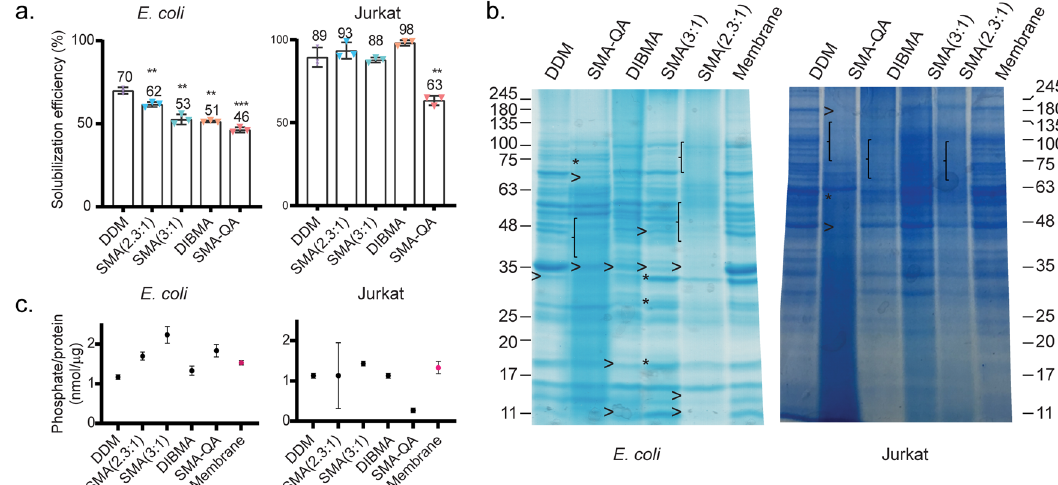
Fig. 2 Solubilization of E. coli and Jurkat membrane pellets with DDM and different xMAs. a Protein solubilization ef fi ciency, as measured by BCA assay of soluble and insoluble fractions after solubilization with DDM or xMAs. Data correspond to three technical replicates. Error bars represent ±S.D. Signi fi cant differences (Student ’ s t test) are denoted as ** p < 0.01, or *** p < 0.001. b Coomassie-stained gels of membrane protein samples solubilized by different xMAs or DDM. An arrowhead or accolade indicates proteins that are substantially lower abundant than in the membrane pellet. Stars indicate examples of protein bands solubilized by one xMA but not or much worse by others. c Ratio of phosphate (measured by determining total inorganic phosphorus) and protein amount present in the soluble fractions or in the membrane, determined by BCA assay. Data points correspond to three technical replicates. Error bars represent